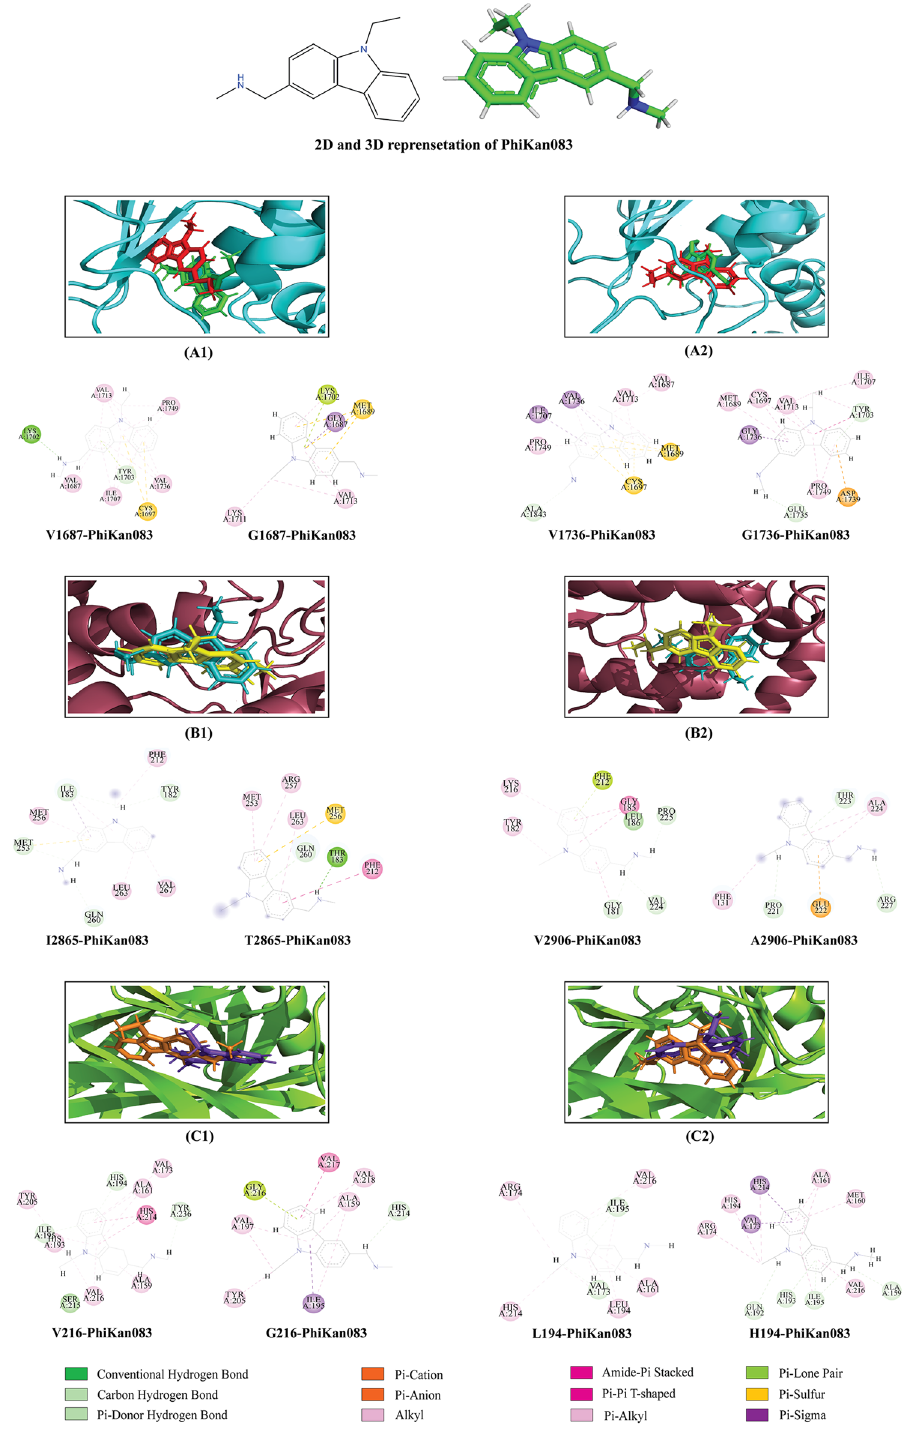
Figure 5. Structure of PhiKan083 and interactions with WT proteins and mutants. The 2D and energy minimized 3D structure of ( A ) PK083. Superimposed images of bonded PK083 docked against WT and mutant proteins in the mutation location are shown here. ( A1,A2 ) PK083 bonded to WT (light green) and mutant (red) BRCT domains. ( B1,B2 ) PK083 bonded to WT (cyan) and mutant (yellow) catalytic domains. ( C1,C2 ) PK083 bonded to WT (purple) and mutant (orange) DNA-binding